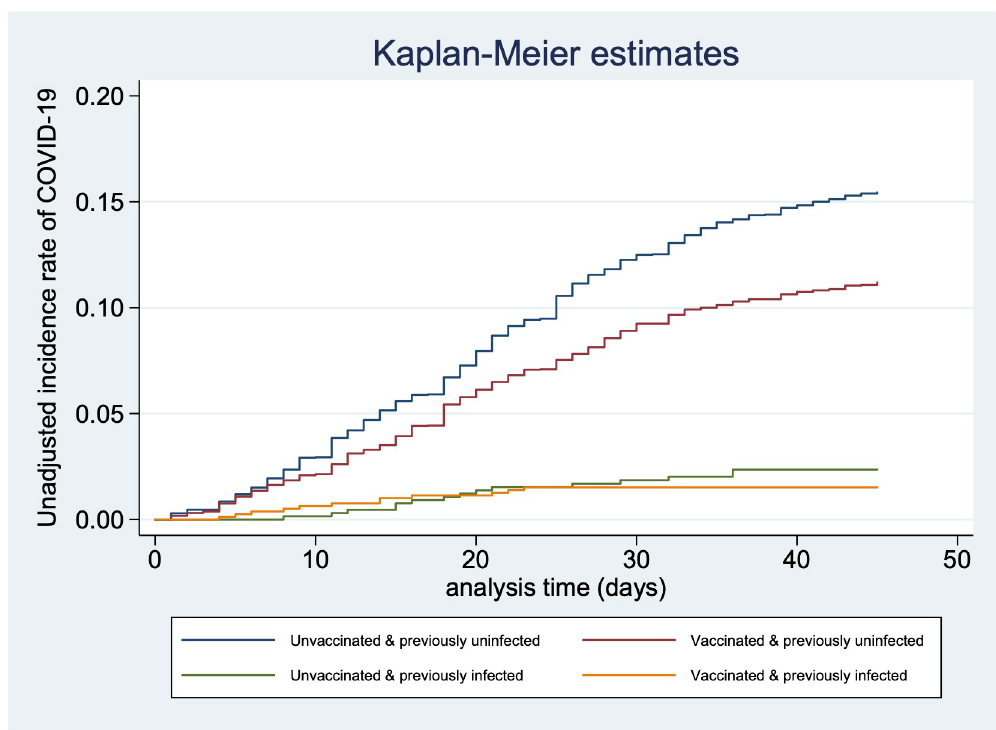
Fig 3. Incidence rates of COVID-19 based on vaccination and prior